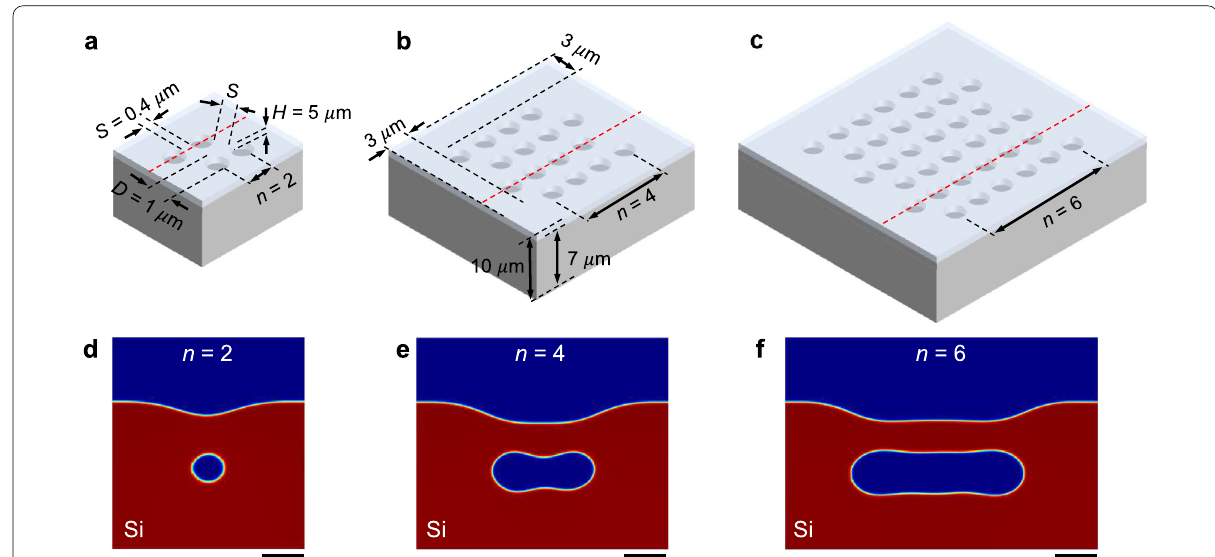
Fig. 1 Three-dimensional simulation results from the identical hole arrays in literature [7] ( D = 1 µ m, S = 0.4 µ m, and AR = H / D = 5 ). a – c Three-dimensional schematics with n = 2 , 4, and 6, respectively. d – f Cross-sectional phase contours at t = 500 s obtained along with center-lines of holes (red-dashed lines in a – c for each n ). All scale bars are 2 µ m